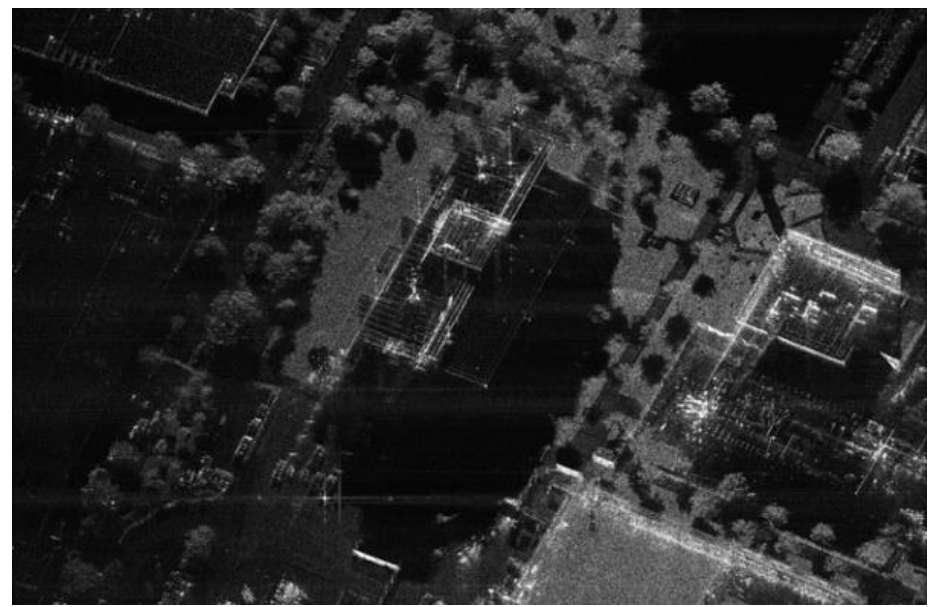
Figure 1. Sandia National Laboratories SAR image of Kirtland AFB Building [39].